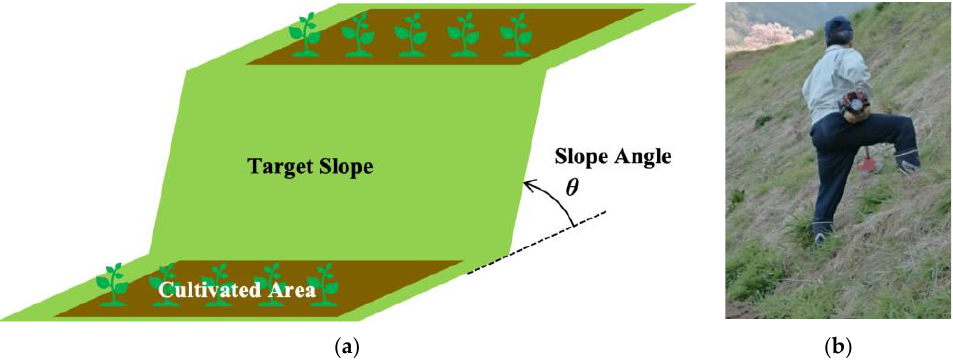
Figure 1. Grass cutting operations on steep slopes in mountainous areas. ( a ) Illustration of a typical gradient between cultivated areas in terraced fields in hilly and mountainous regions. ( b ) Grass cutting on a steep slope.